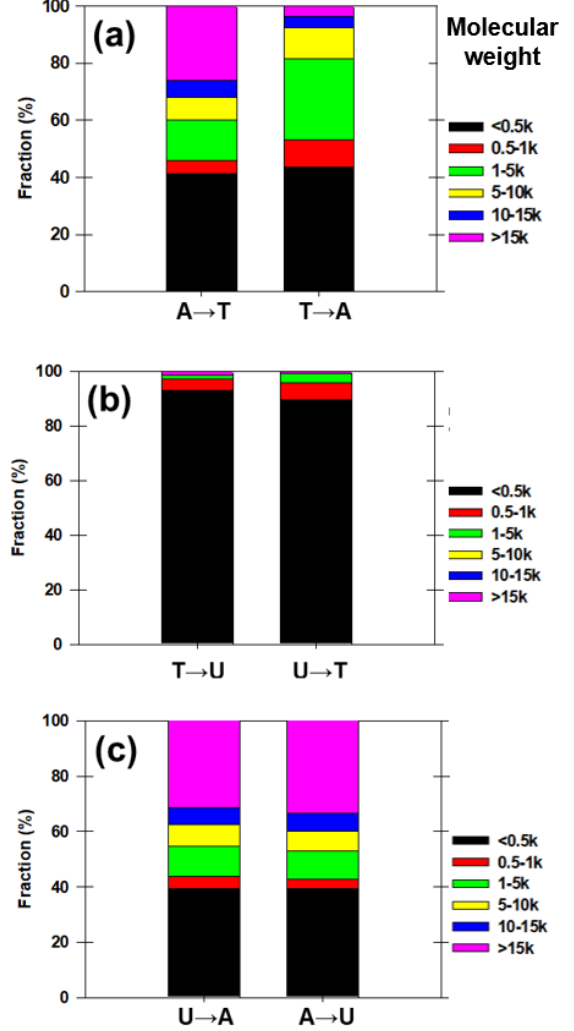
Figure 2. Molecular weight distribution comparison between filtrates of ( a ) alkaline → thermal vs. thermal → alkaline, ( b ) thermal → ultrasonic vs. ultrasonic → thermal, and ( c ) ultrasonic → alkaline vs. alkaline → ultrasonic pretreatments.